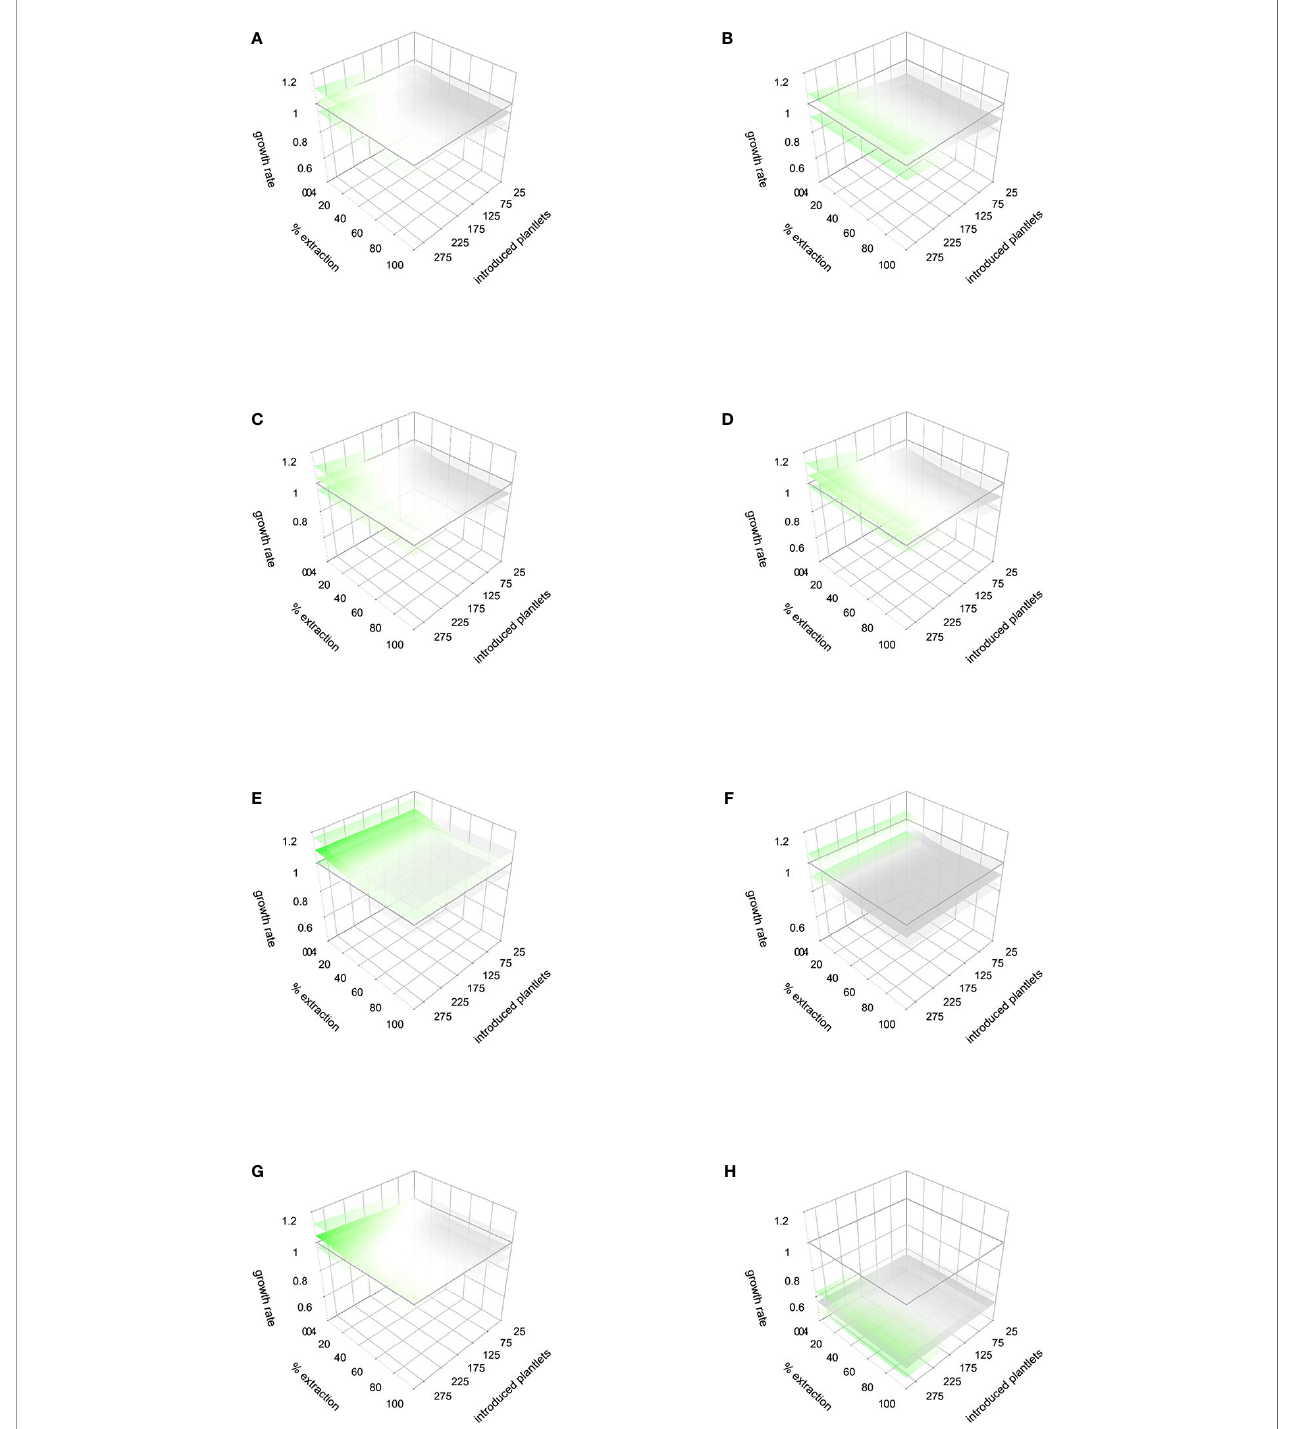
FIGURE 5 | Response to management simulations and stochastic rainfall models for the two monitored periods ( fi rst and second years of the study, respectively). Cuanajo (A) fi rst period, (B) second period. Icuacato (C) fi rst period, (D) second period (Forest fi re). Piedra de Indio: (E) fi rst period, (F) second period. Pino Real: (G) fi rst period, (H) second period. Values of l below 1 are gray colored, values equals 1 are white colored, and l values over 1 are green colored. Lower and upper l responses to the lower and upper rainfall thresholds are represented in shaded